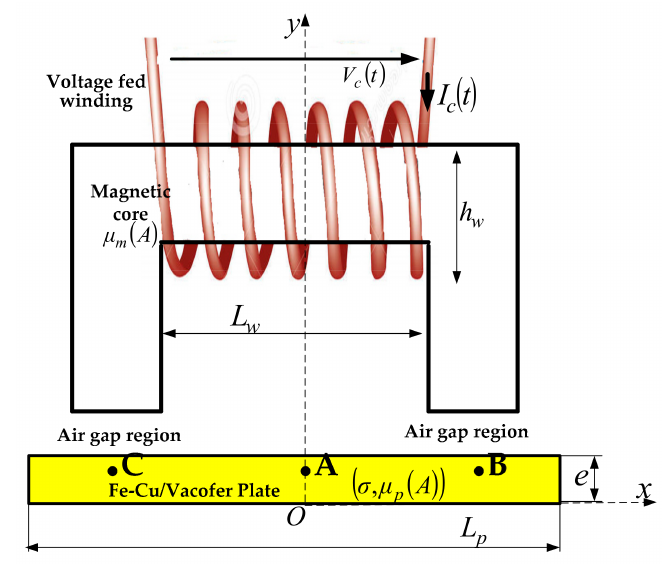
Figure 2. Typical components of the electromagnetic